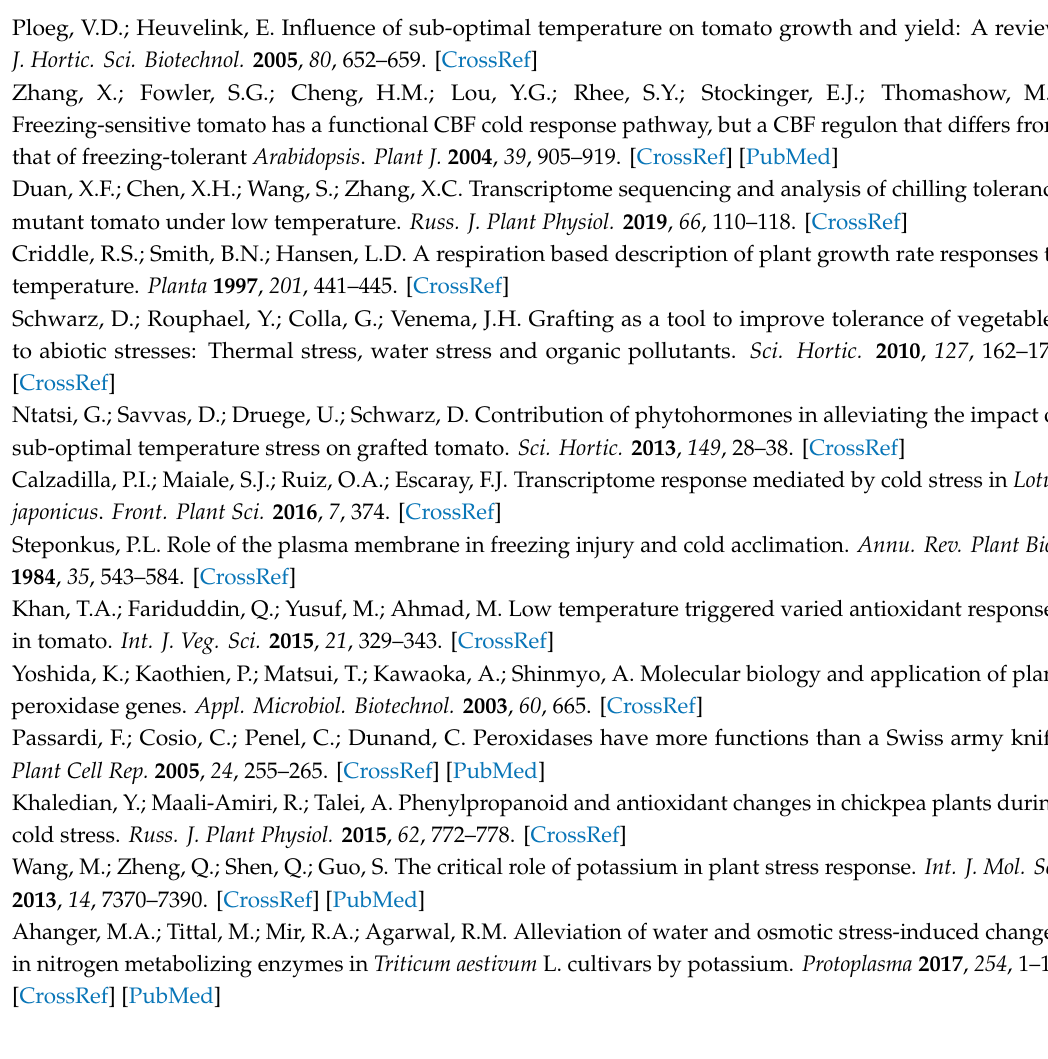
Table S1: Major characteristic of twelve libraries. Table S2: The DEGs in the S708 cultivar. Table S3: The DEGs in the T722 cultivar. Table S4: Significantly enriched GO biological process terms of DEGs in both tomato cultivars under sub-optimal temperature stress. Table S5: KEGG pathway enrichment analysis of DEGs. Table S6: List of aquaporins and cold tolerance related genes in the S708 and T722 cultivar under sub-optimal temperature conditions. Table S7: Primers used in qPCR